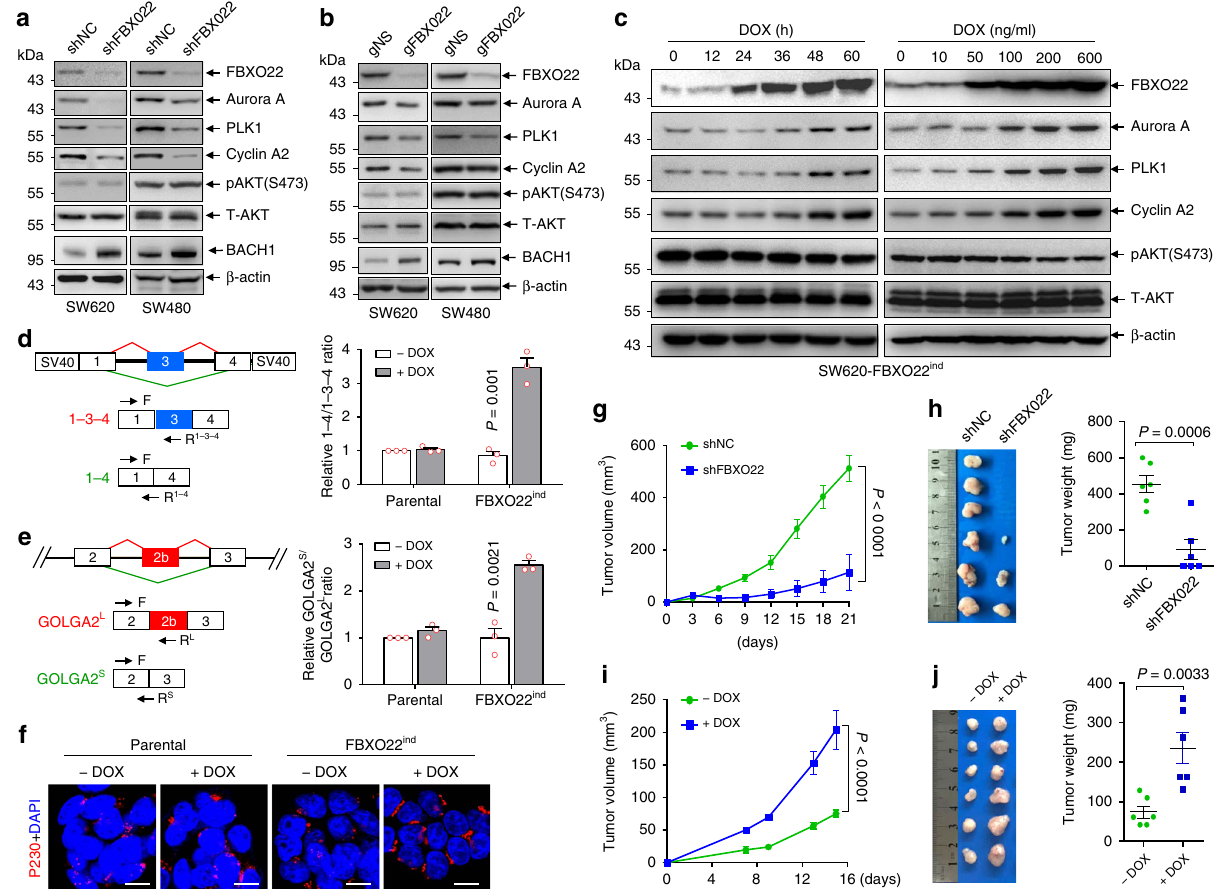
Fig. 4 FBXO22 suppresses nuclear PTEN signaling and promotes tumorigenesis. a , b Western blots of indicated proteins in SW620 and SW480 cells transduced by retroviruses encoding shFBXO22 or shNC ( a ) and lentiviruses encoding CAS9 and gFBXO22 or gNS ( b ). c Western blots of indicated proteins in SW620-FBXO22 ind cells by DOX administration for indicated times (left) or concentrations (right). d , e Left, schematic representation of pTWT reporter gene ( d ) and a part of GOLGA2 gene ( e ) with exons shown as boxes. Splicing patterns are shown as diagonal red (included) or green (excluded) lines, with the two corresponding splicing products shown below. Arrows indicate the locations of primers used in qRT-PCR. Right, qRT-PCR analysis of indicated splicing ratios in parental SW620 or SW620-FBXO22 ind cells with or without DOX administration. f Representative images of immuno fl uorescent staining of p230 together with re-staining of DAPI in SW620-FBXO22 ind cells with or without FBXO22 induction by DOX administration. Scale bar represents 10 μ m. g , h SW620 cells with or without FBXO22 knockdown by shRNA were subcutaneously injected into nude mice (3 × 10 6 cells per mouse). Tumor volumes were measured at different days ( g ). On day 21 after subcutaneous injection, tumors were harvested and weighted ( h ). i , j SW620-FBXO22 ind cells were subcutaneously injected into nude mice (1.5 × 10 6 cells per mouse). Mice were administrated with or without 600 mg/kg DOX in feed immediately after subcutaneous injection. Tumor volumes were measured at different days ( i ). On day 15 after subcutaneous injection, tumors were harvested and weighted ( j ). The experiments shown in a – c , f were repeated three times with similar results, and the results of one representative experiment are shown. The data in d , e are presented as the mean ± SEM, n = 3 independent experiments; statistical signi fi cance was determined by two-tailed unpaired t -test and the P value is shown. The data in g – j are presented as the mean ± SEM, n = 6 biologically independent samples; two-way ANOVA for g , i and two-tailed unpaired t -test for h , j . Source data are provided as a Source Data fi 4 surrounded by fl anking regulatory sequences and generates two exon 2b (Fig. 4e), leading to the extension of Golgi Apparatus as mRNA isoforms, 1-3-4 and 1-4 by alternative splicing (Fig. 4d, assessed by immuno fl uorescent staining of p230 (Fig. 4f), left) 44 , or the double-reporter minigene pTN24 in which β - mirroring the suppressive role of PTEN on GOLGA2 exon 2b galactosidase ( β -gal) is constitutively express while luciferase is skipping and Golgi extension 20 . All these results indicate that FBXO22 regulates the downstream signaling of nuclear PTEN. expressed only if appropriate splicing removes an upstream To evaluate the role of FBXO22 on tumorigenesis, we showed intron that contains translational stop codons (Supplementary that knockdown of FBXO22 in SW620 cells by shRNA Fig. 4f, top) 45 , were transiently transfected into SW620- dramatically suppressed subcutaneous tumor growth (Fig. 4g, FBXO22 ind cells. The results showed that the induced expression h). On the other hand, after subcutaneous injection of SW620- of FBXO22 by DOX treatment caused a decreased splicing ratio FBXO22 ind cells, mice were administrated with or without DOX of both minigenes, as detected respectively by the increased ratio in feed according to a previous report 46 . DOX administration of exon 3 excluded/included isoform (Fig. 4d) and the decreased induced tumoral FBXO22 overexpression (Supplementary Fig. 4g) luciferase/ β -gal ratio (Supplementary Fig. 4f), indicating that and promoted tumor growth (Fig. 4i, j). Thus, FBXO22 plays a FBXO22 regulated the splicing of these minigenes. Moreover, tumor-promoting role. overexpression of FBXO22 induced the skipping of GOLGA2